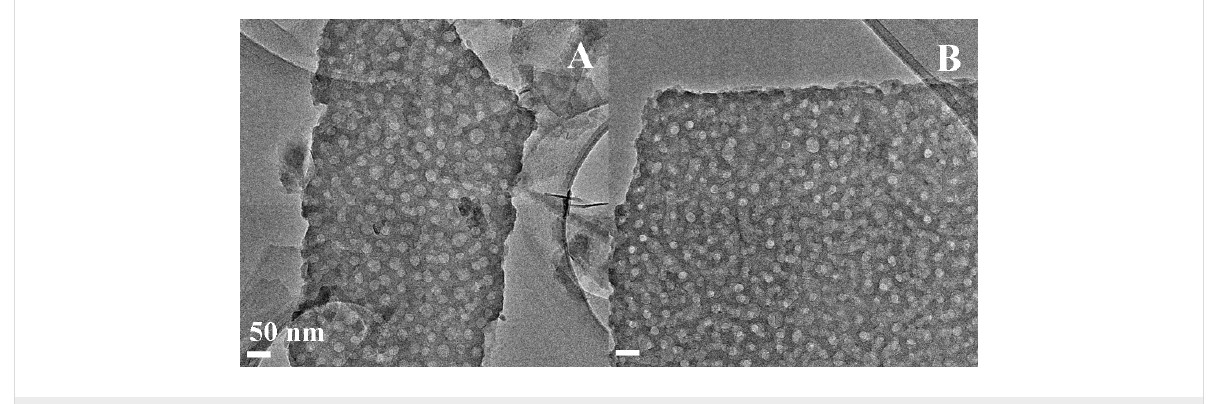
Figure 3: HRTEM micrographs of calcined TEOS/PS 120 - b -PEO 318 films obtained at different TEOS/PS- b -PEO ratios, namely: 95/5 (A) and 93/7 (B). All micrographs were collected at the same magnification.